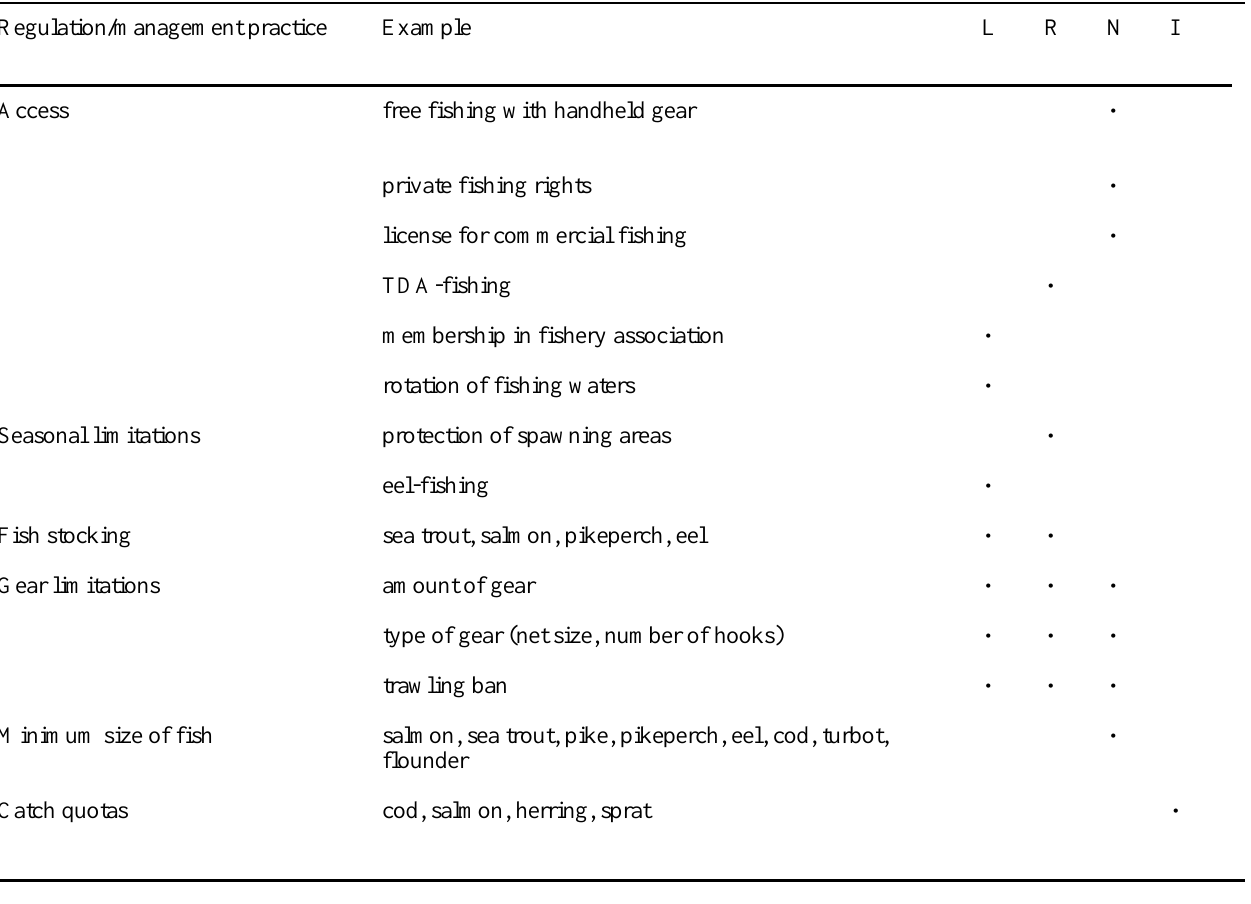
Table 4. Fisheries regulations and management practices at the local (L), regional (R), national (N), and international (I) levels identified in Ornö and Möja